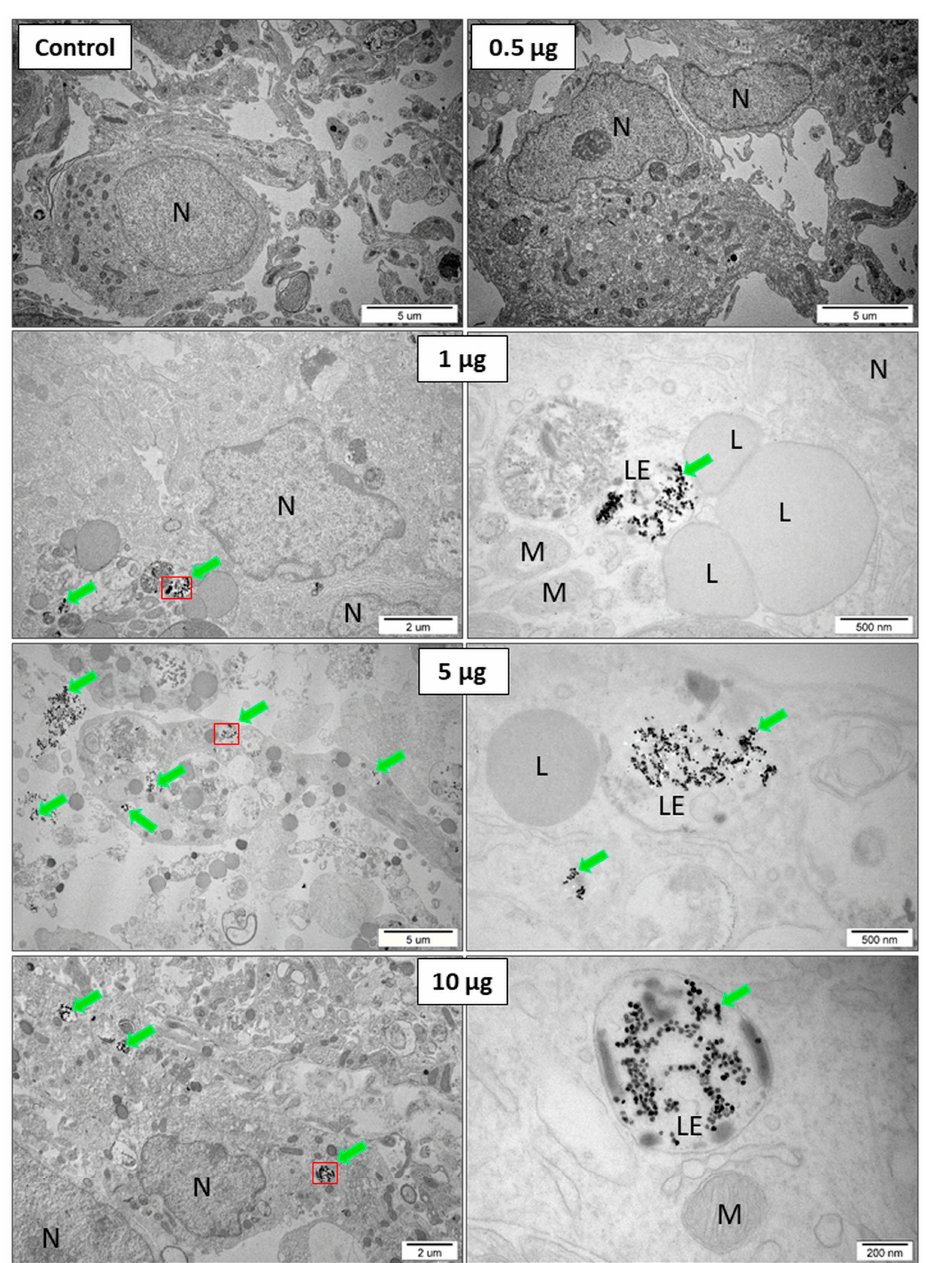
Figure 3. Variant 3. The OHSCs, after 2 h of incubation without UCNPs (control) and with 0.5; 1; 5, and 10 μ g 4 μ L − 1 of UCNPs applied as droplets on the surface of sliced placed on the membrane. Aggregates of UCNPs are marked with green arrows. UCNPs inside endosomes are marked with a green arrow and a red outline (at a higher magnification next to it), N—nucleus; L—lysosome; M—mitochondria; and LE—late